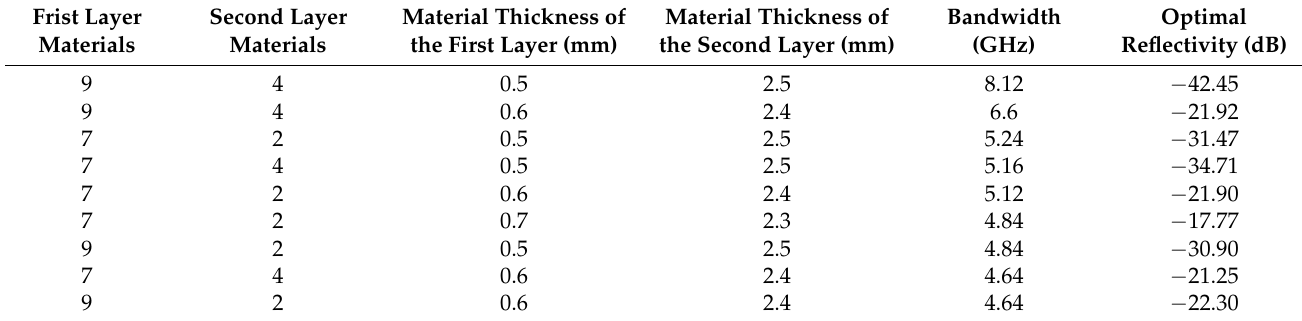
Table 8. The optimization results using objective function F2 (three-layers) of ABC algorithm. Table 6. The optimization results using objective function F1 (two-layers) of ABC algorithm.